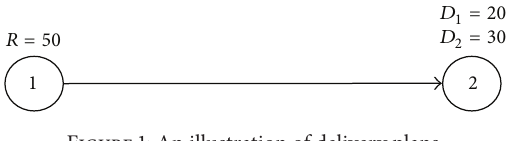
Figure 1: An illustration of delivery plans.